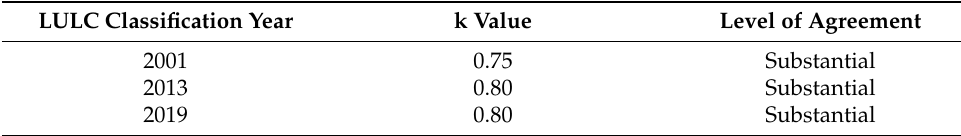
Table 3. Kappa values for the 2001, 2013, and 2019 supervised